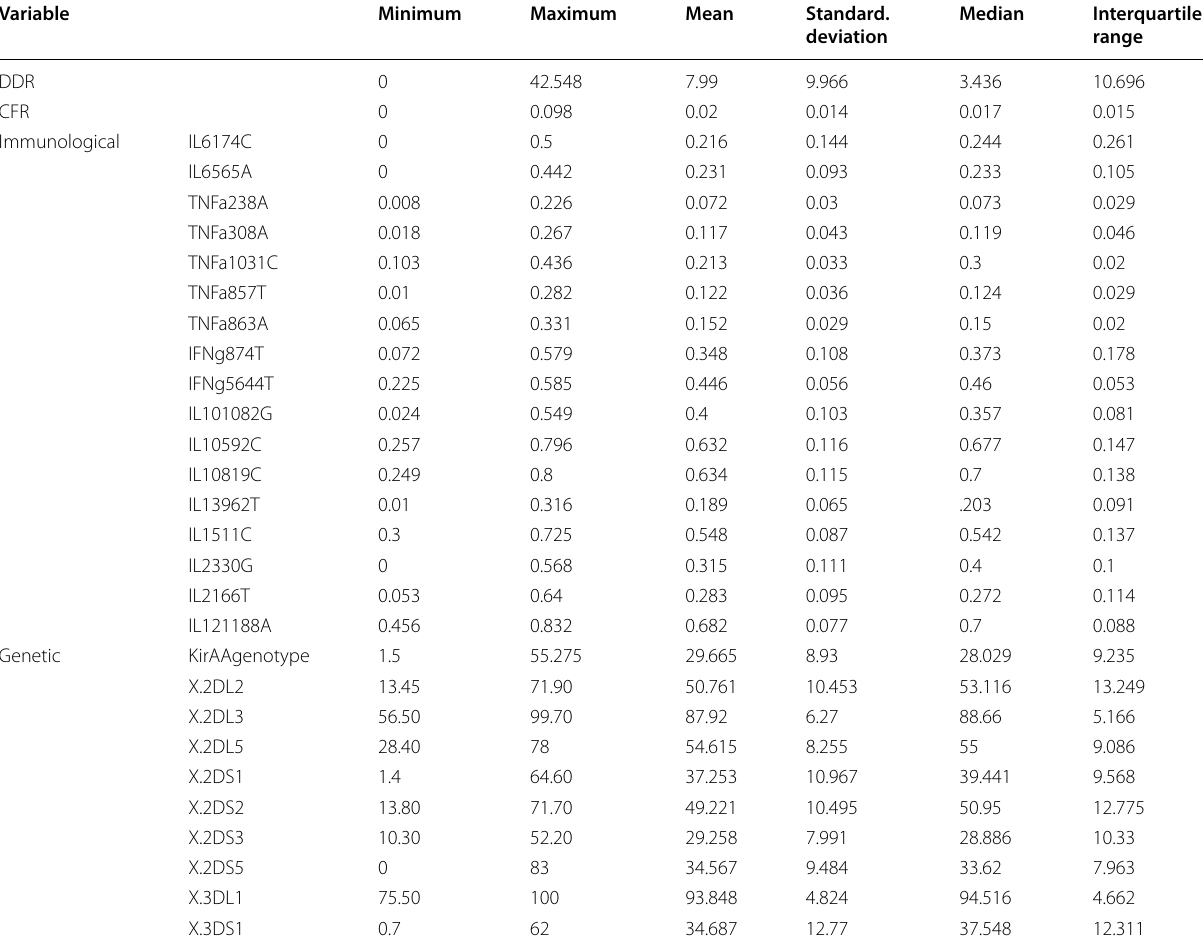
Table 3 Descriptive statistics of DDR, CFR, immunological and genetic variables